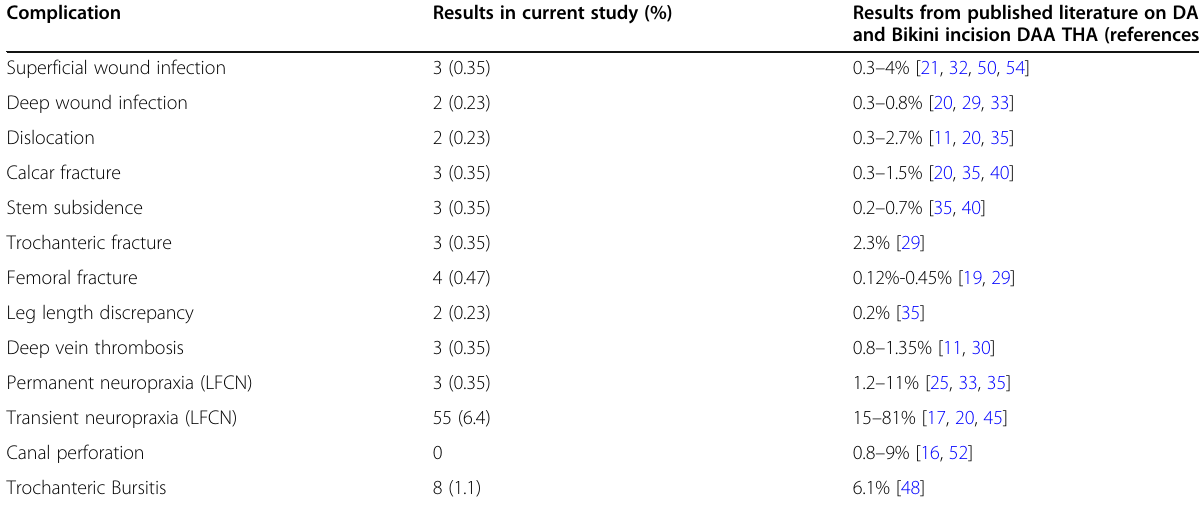
Table 1 Overview of complications found in our series (851 hips with average 3.9 years follow-up) and results from published studies on DAA and bikini incision DAA THA